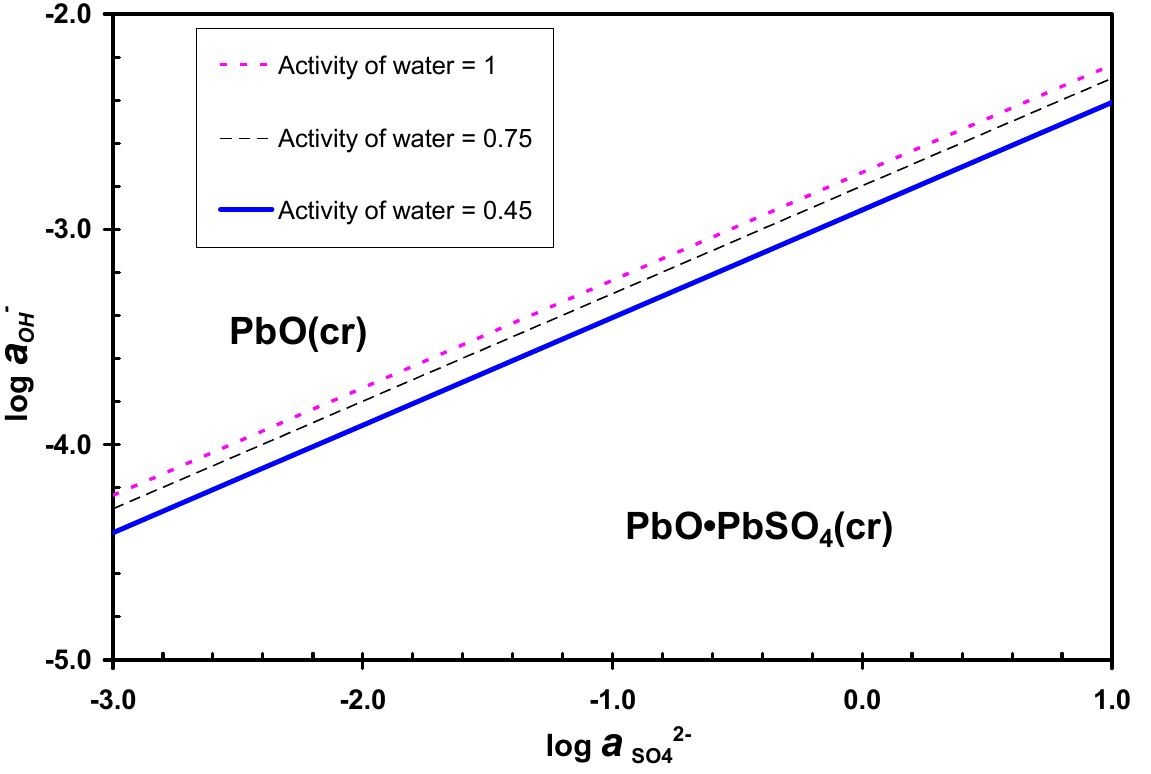
Figure 9. The stability fields of lead dioxide [PbO(cr)] and lead oxide sulfate [PbO • PbSO 4 (cr)] at 25 ◦ C in the space of log a versus log a OH − SO 2 − 4 in alkaline solutions for desulphurization of lead pastes at water activities of 1.0, 0.75, and 0.45, respectively.